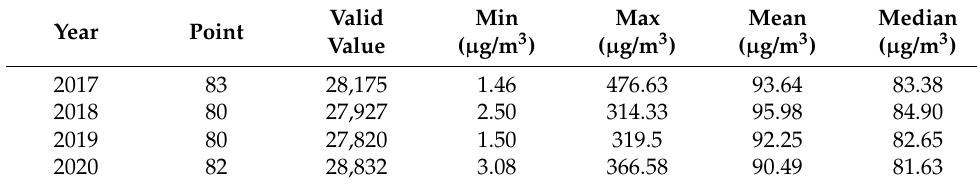
Table 1. Statistics of daily maximum 8 h average O 3 concentration.